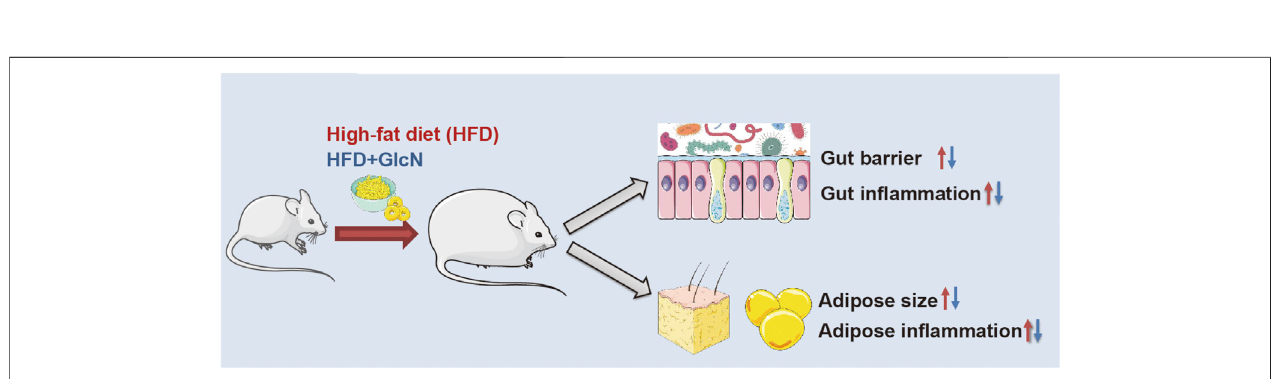
FIGURE 10 | Graphical overview of possible mechanisms by which GlcN improved glucolipid metabolism disorder of HFD-fed mice.